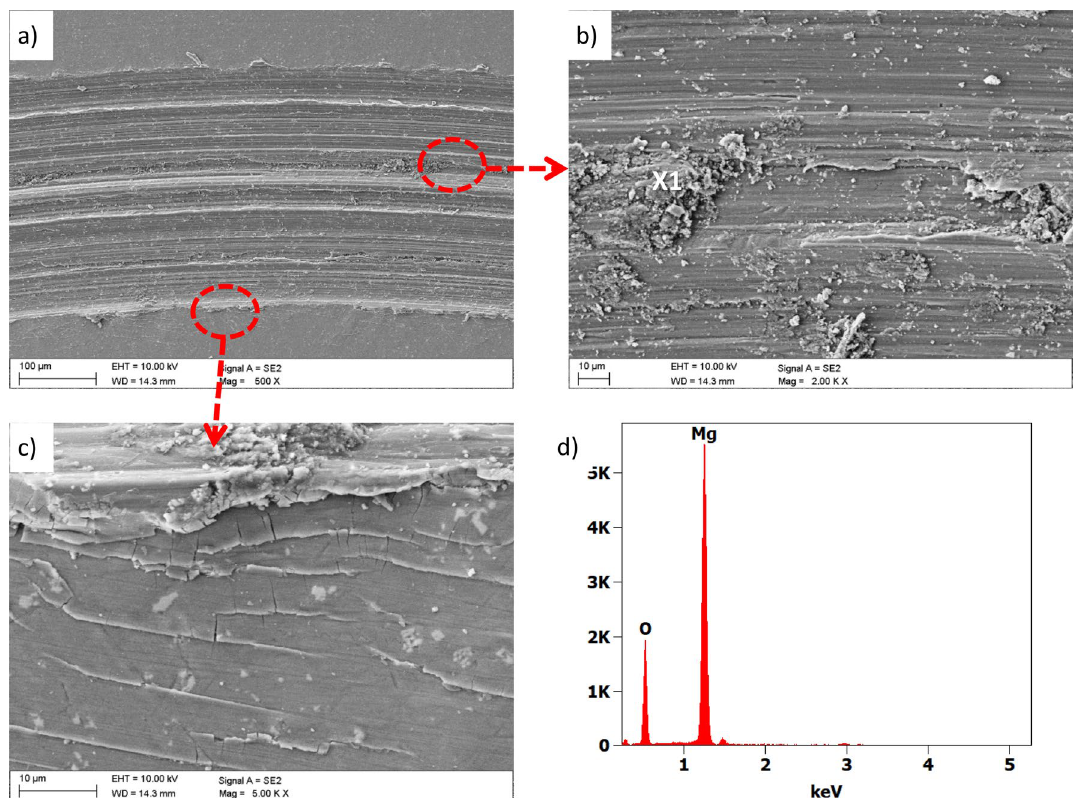
Figure 19. Wear trace after the "ball-on-plate" wear test for the Ti + TiO 2 /Al 2 O 3 + TiO 2 hybrid coating on AE42 alloy substrate, ( a – c ) SEM images, ( d ) X-ray energy dispersive plot of the area X1 shown in ( b ).